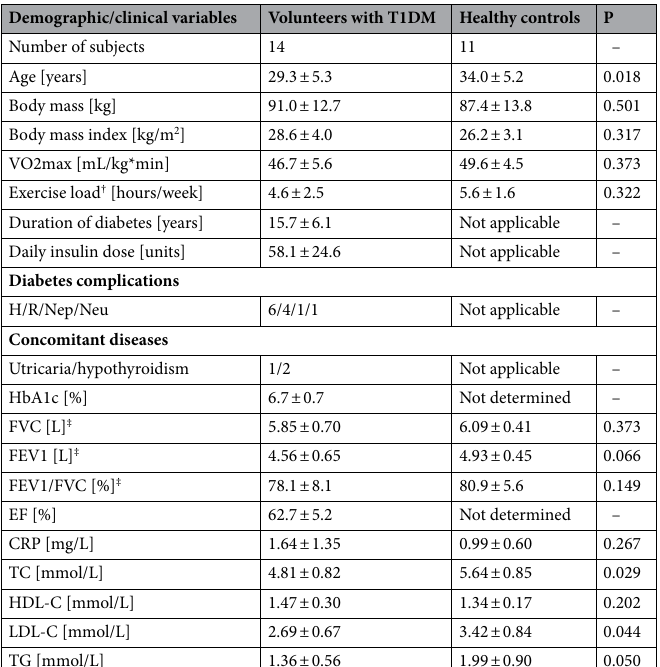
Table 1. Characteristic of the studied groups of T1DM volunteers and healthy controls. T1DM type 1 diabetes mellitus, H arterial hypertension, R retinopathy, Nep nephropathy, Neu neuropathy, HbA1c glycated haemoglobin, FVC forced vital capacity, FEV1 forced expiratory volume in the first second, EF ejection fraction, CRP-C reactive protein, TC total cholesterol, HDL-C high-density lipoprotein cholesterol, LDL-C low-density lipoprotein cholesterol, TG triglycerides. † Cross country running, treadmill running or soccer. ‡ Similarly, no differences were noted when the parameter was expressed as percent of predicted.